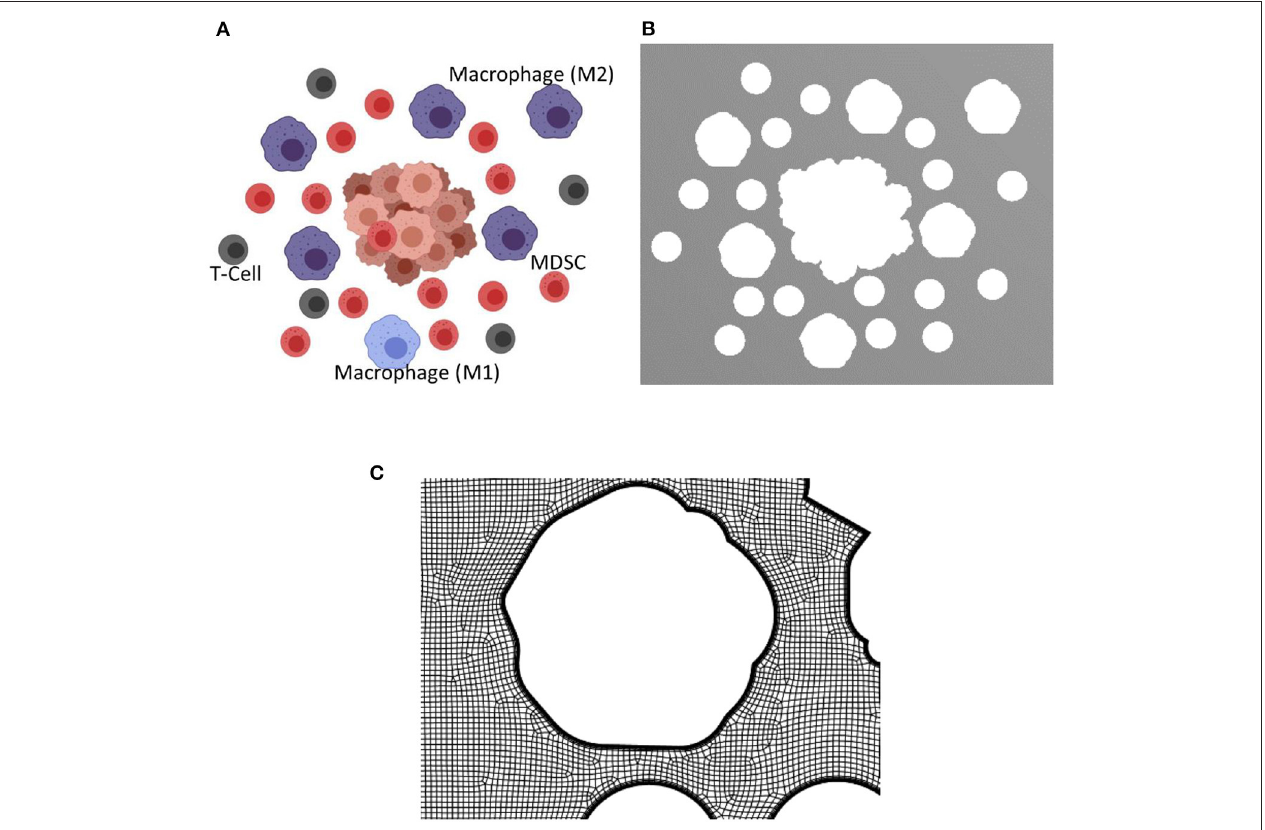
FIGURE 5 | Biorender image, computational domain, and a view of the mesh for the tumor microenvironment with macrophages, T cells, and MDSCs. The tumor microenvironments used for the simulations are created using Biorendor (48), and the rendered images is segmented to extract the geometry of various cell types in the computational domain. (A) Rendered image using Biorender. (B) Extracted computational domain using image processing techniques. (C) A zoomed in view of the mesh in TME used for the computational simulation.